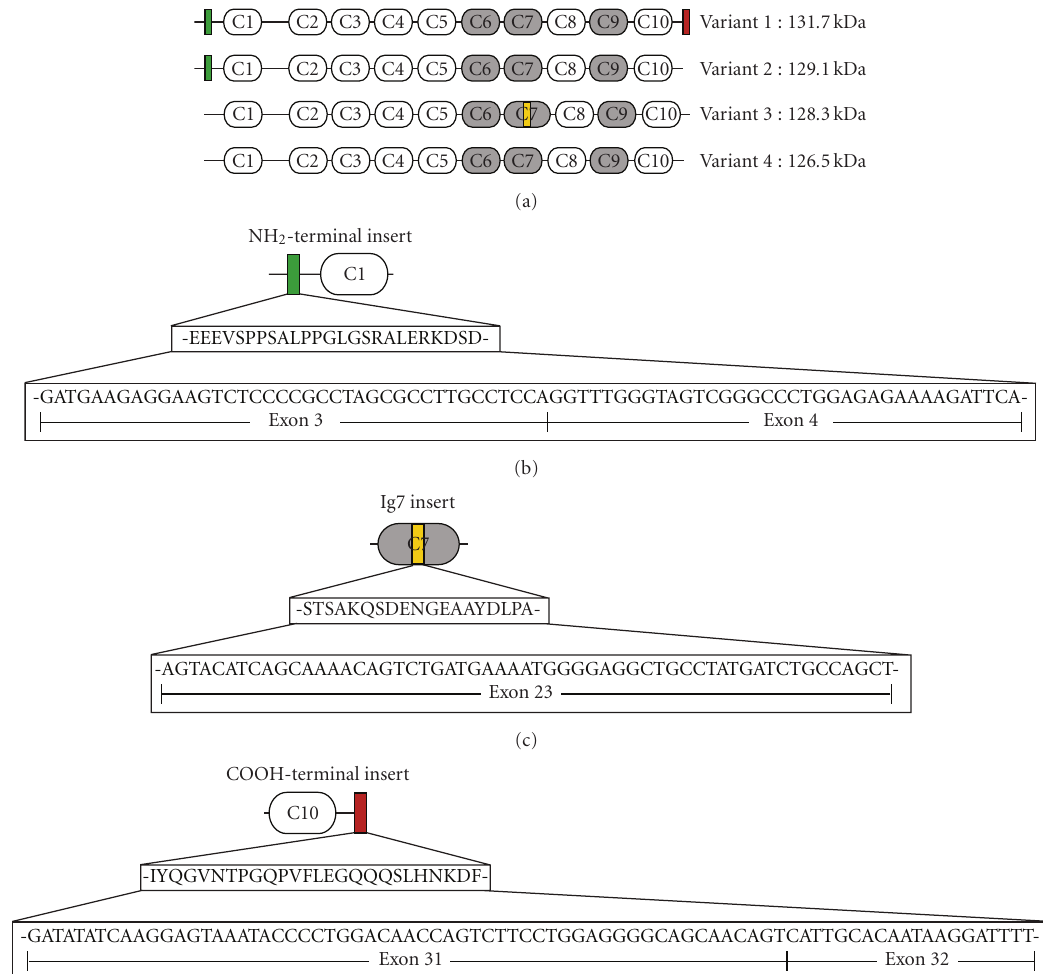
Figure 1: (a): Schematic representation of MyBP-C slow variants 1–4, showing their common structural motifs and novel insertions; white and grey ovals represent Ig and FN-III domains, respectively, while green, yellow, and red rectangles correspond to the NH 2 -terminal, Ig7, and COOH-terminal inserts, respectively. The NH 2 -terminal insert is present in variants 1 and 2, while the Ig7 and COOH-terminal inserts are present in variants 3 and 1, respectively. Variant 4 does not contain any of the three inserts. (b–d): Complex alternative splicing events result in the inclusion of exons 3 and 4, exon 23 and exon 31 that encode the NH 2 -terminal (b), Ig7 (c), and COOH-terminal (d) novel insertions. The amino acid and nucleotide compositions of the three insertions are